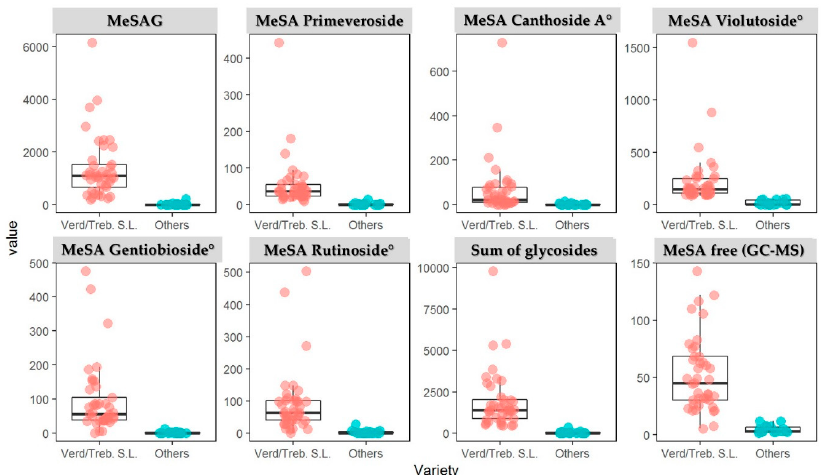
Figure 5. Content of MeSA-monoglycoside, MeSA-diglycosides and methyl salicylate (MeSA) in free form (value in μ g/L) in Verdicchio, Trebbiano di Soave and Lugana wines compared to other Italian and international varieties . ( ° quantified as MeSA-primeveroside)